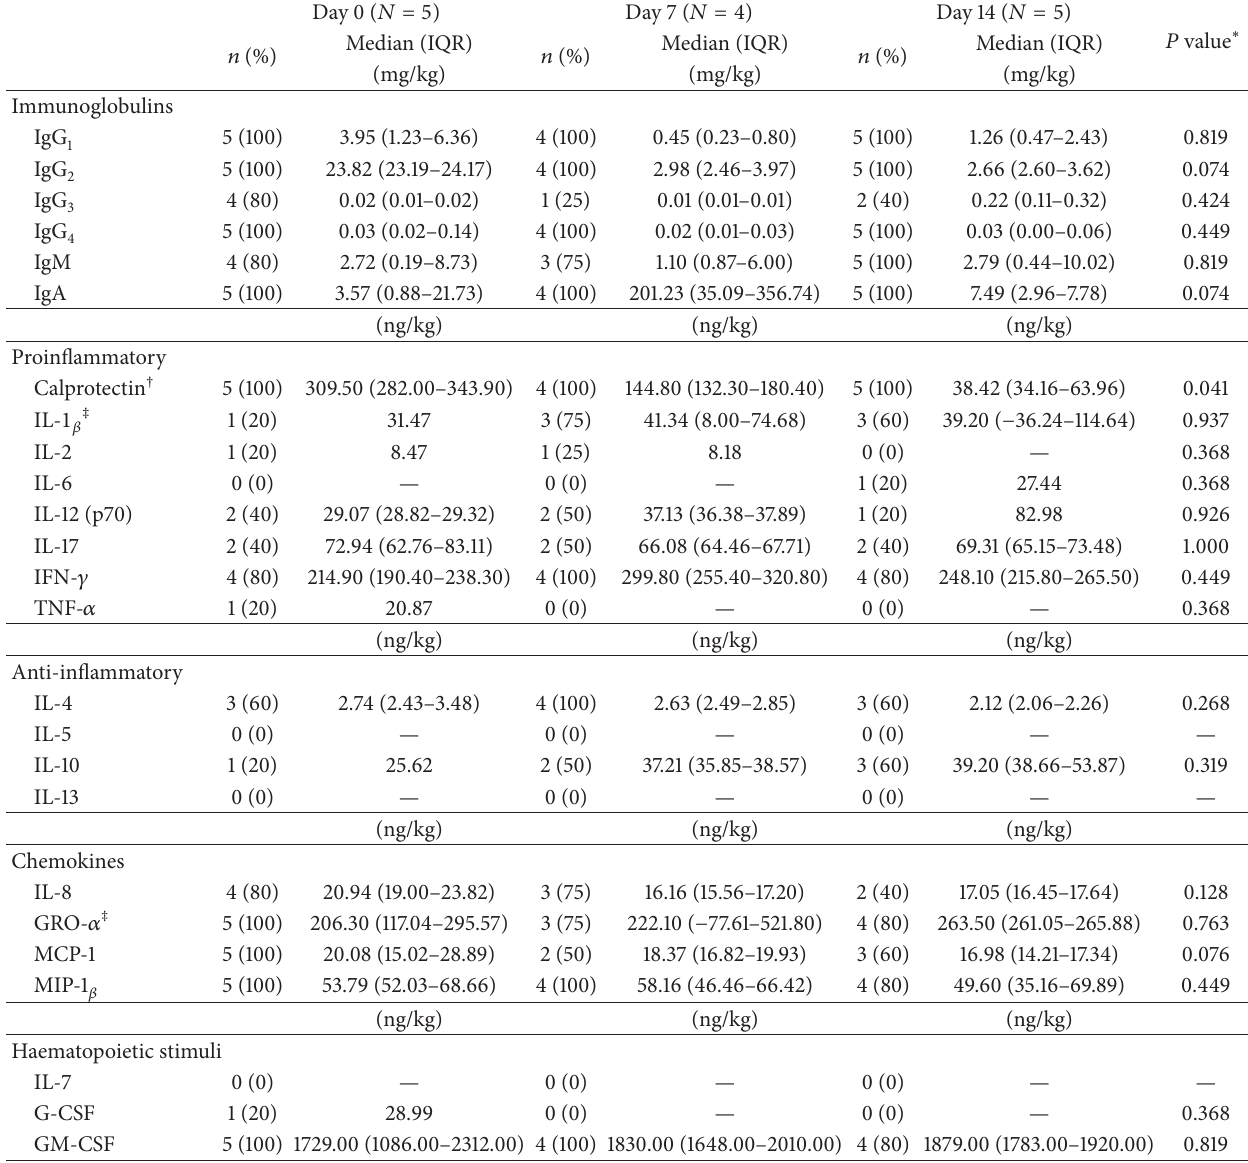
Table 2: Frequency and concentration of immune compounds in fecal samples ( 𝑁 = 14 ) along